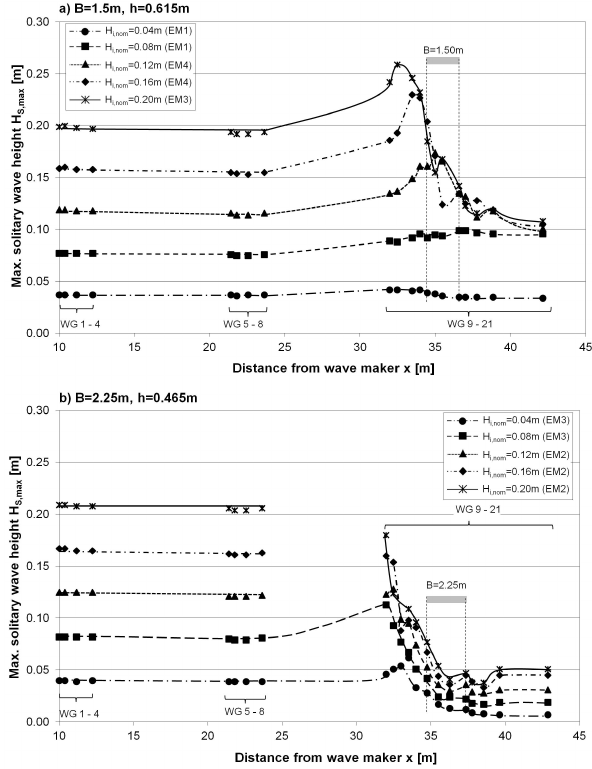
Fig. 9. Selected envelopes of solitary wave height: (a) in case of for- est width B = 1.5m and water depth h = 0.615m, (b) in case of for- est width B = 2.25m and water depth h = 0.465m (see also Fig. 7 for wave evolution modes and Fig. 5a for wave gauge